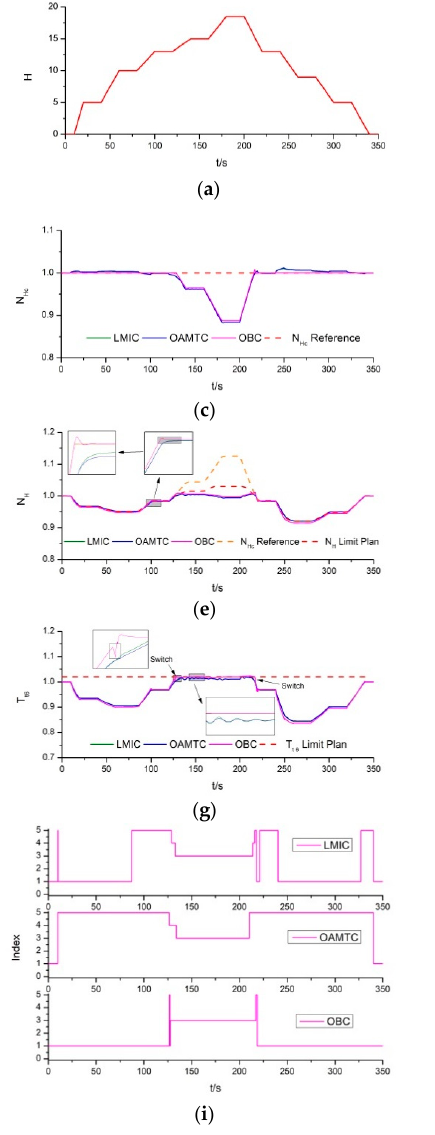
Figure 17. Simulation results under full power condition within the whole flight envelope: ( a ) Altitude; ( b ) Mach number; ( c ) Corrected high-pressure rotor speed response; ( d ) Low-pressure rotor speed response; ( e ) High-pressure rotor speed response; ( f ) High-pressure compressor outlet total pressure response; ( g ) Mixing chamber inlet total temperature response; ( h ) Control Input; ( i ) Controller index.